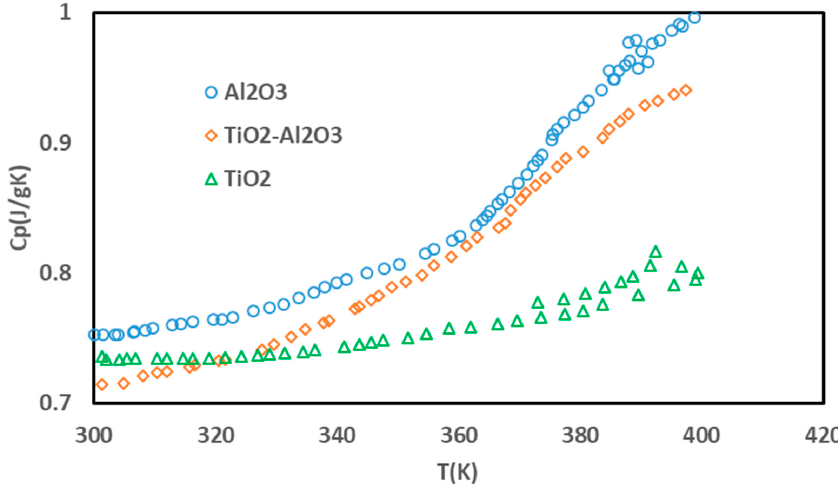
Figure 3. The results of the specific heat capacity of the nanocomposite.